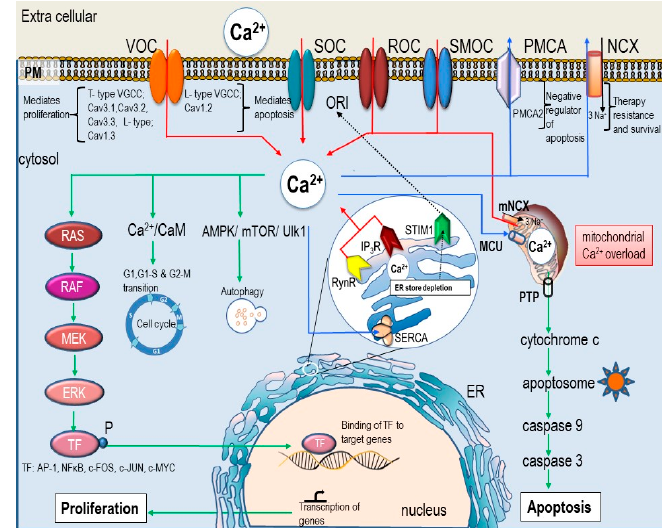
Figure 1. Ca 2 + -signaling in proliferation and apoptosis. [Ca 2 + ] i homeostasis of the cell is strictly regulated by various channels and pumps on plasma membrane, ER, and mitochondria. Intracellular calcium flux is indicated by arrows where red arrows indicate influx of Ca 2 + ions, blue arrows indicate Ca 2 + e ffl ux and sequestration of Ca 2 + into the stores, and green arrows indicate cell signaling pathways which are activated by [Ca 2 + ] i. Primarily Ca 2 + influx from the extra-cellular space is controlled by VOC (voltage operated calcium channel), SOC (store-operated Orai channels), SMOC (second messenger-operated channel), or ROC (receptor-operated channel), and Ca 2 + e ffl ux is mediated via (NCX (Na + / Ca 2 + exchanger) and PMCA (plasma membrane Ca 2 + -ATPase). Ca 2 + release from the ER stores is facilitated via RyR (ryanodine receptors) and IP 3 R (IP 3 receptor). Uptake of calcium from the cytosol is an energy driven process mediated by SERCA (sarcoplasmic / ER Ca 2 + -ATPase). Additionally, mitochondria and associated proteins (including mitochondrial calcium uniporter (MCU), voltage dependent anion channel (VDAC), and mitochondrial Na + / Ca 2 + exchanger (mNCX) are also related to [Ca 2 + ] i -regulation. Mitochondrial-Ca 2 + controls ATP synthesis, apoptosis, ROS generation, and biosynthesis and can determine the fate of the cell. The concentration of Ca 2 + in the cytosol is maintained at a low level (100 nM) in comparison to the extra cellular Ca 2 + (1mM). Any change in the [Ca 2 + ] i results in signal transduction initiating various cellular process such as apoptosis, proliferation, and cell division. The type of signal depends on the duration, amplitude, localization, frequency, and oscillation. Sustained high level of Ca 2 + in the mitochondria causes the release of cytochrome c and subsequently triggers death signals via caspase activation. More Ca 2 + influx from the ion channels on the plasma membrane can trigger either proliferation (via T-type) or apoptosis (via L-type). Increased Ca 2 + entry through the SOC channel promotes proliferation